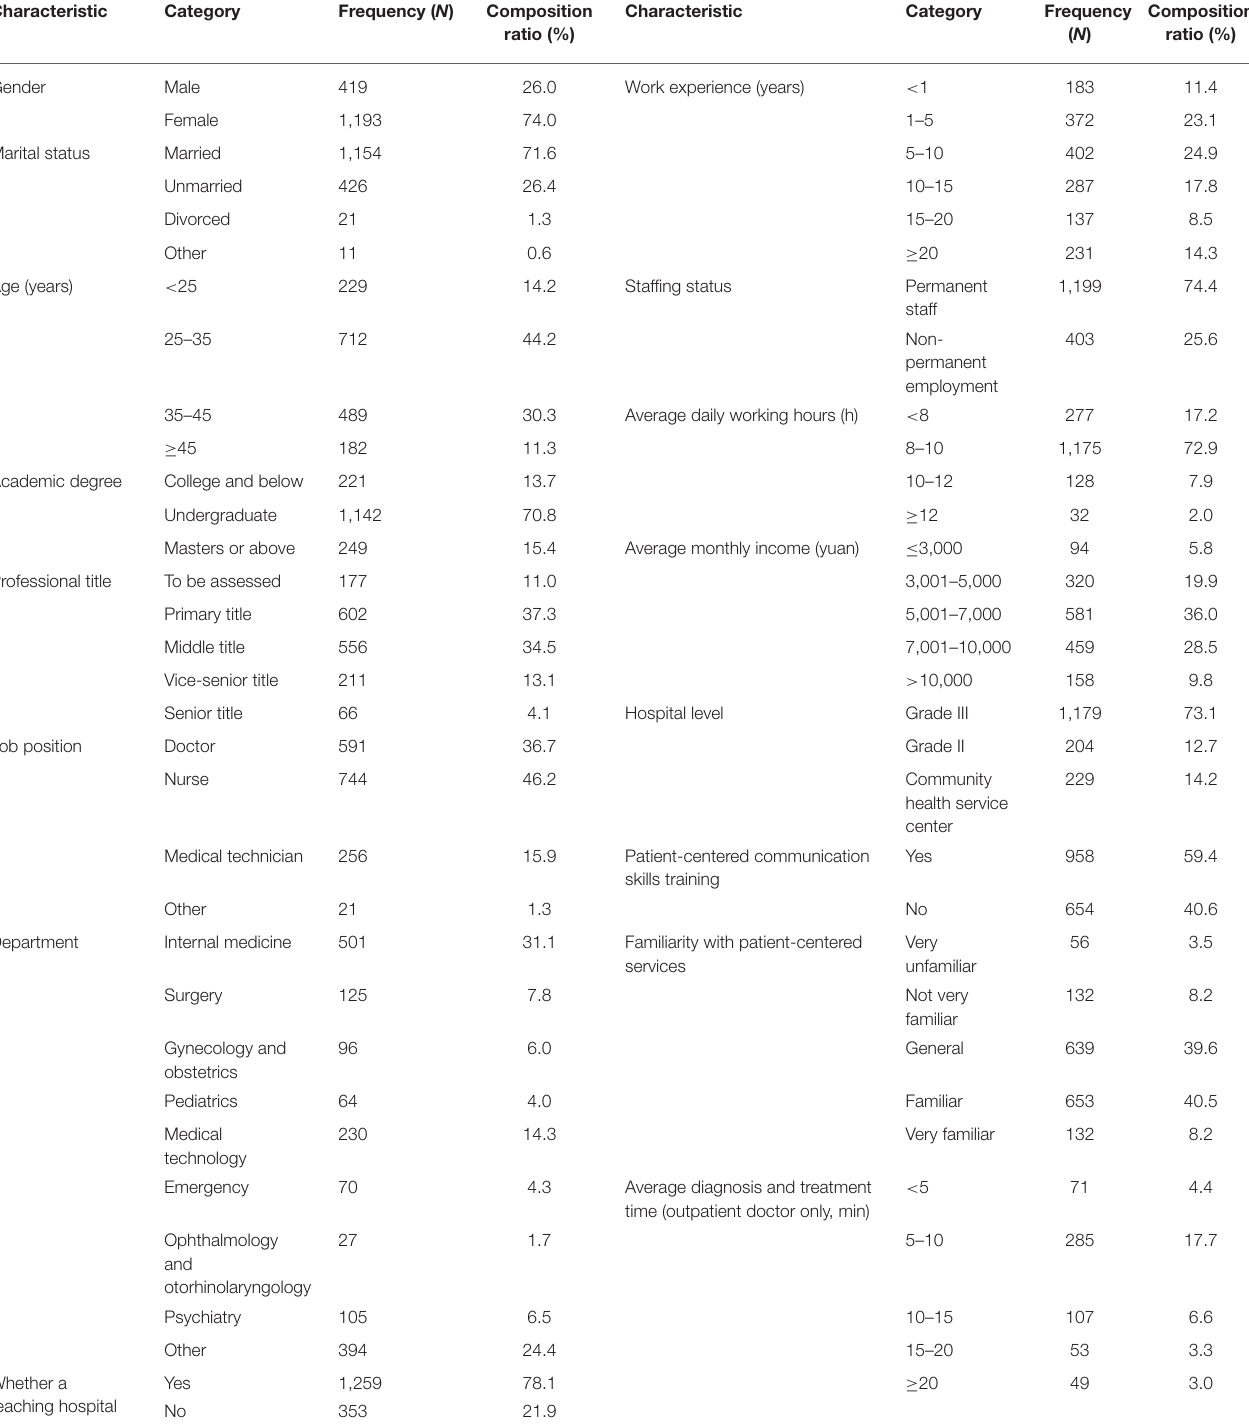
TABLE 1 | Descriptive statistics of the sample ( N =